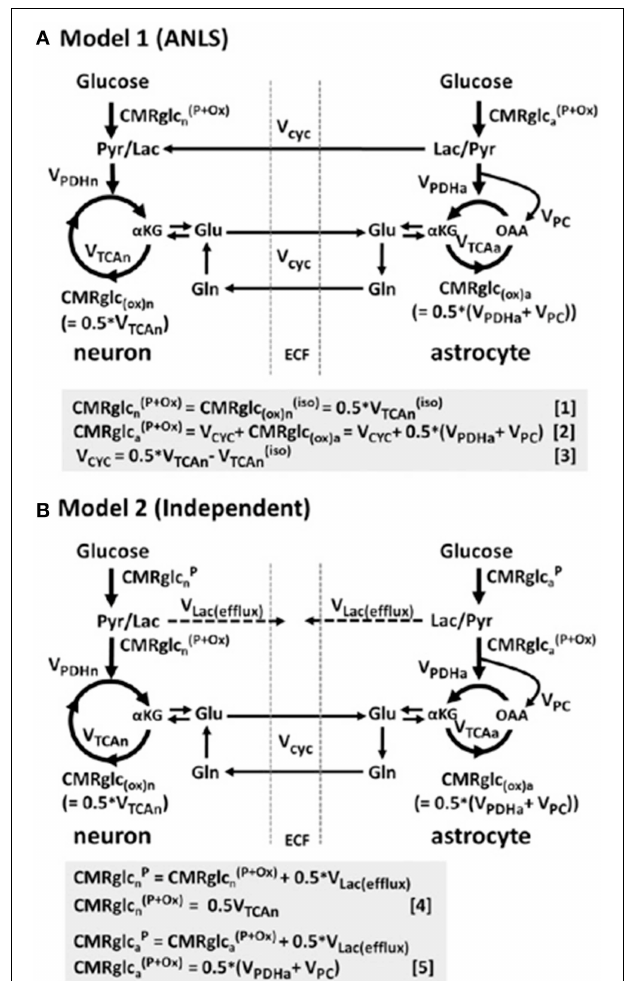
FIGURE 10 | Schematic depiction of two neuroenergetics models under consideration to account for the 1:1 flux relationship between increments in the rate of glutamate/glutamine cycling (V cyc ) and the TCA cycle flux in neurons (V TCAn ). (A) ANLS-type model (Model 1). (B) Independent-type model (Model 2) in which neurons and astrocytes take up and oxidize glucose according to their respective energy needs. Phosphorylated glucose not oxidized within the cell may be effluxed as lactate, V Lac(efflux) , which is shown by dashed lines. The results of this study in rat brain suggested that neurons are capable of supporting a substantial fraction of their substrate requirements by direct uptake and phosphorylation of glucose. Originally published by Patel et al. (2014) in Proc Natl Acad Sci USA 111: 5385–5390, and reproduced with permission from Proc Natl Acad Sci